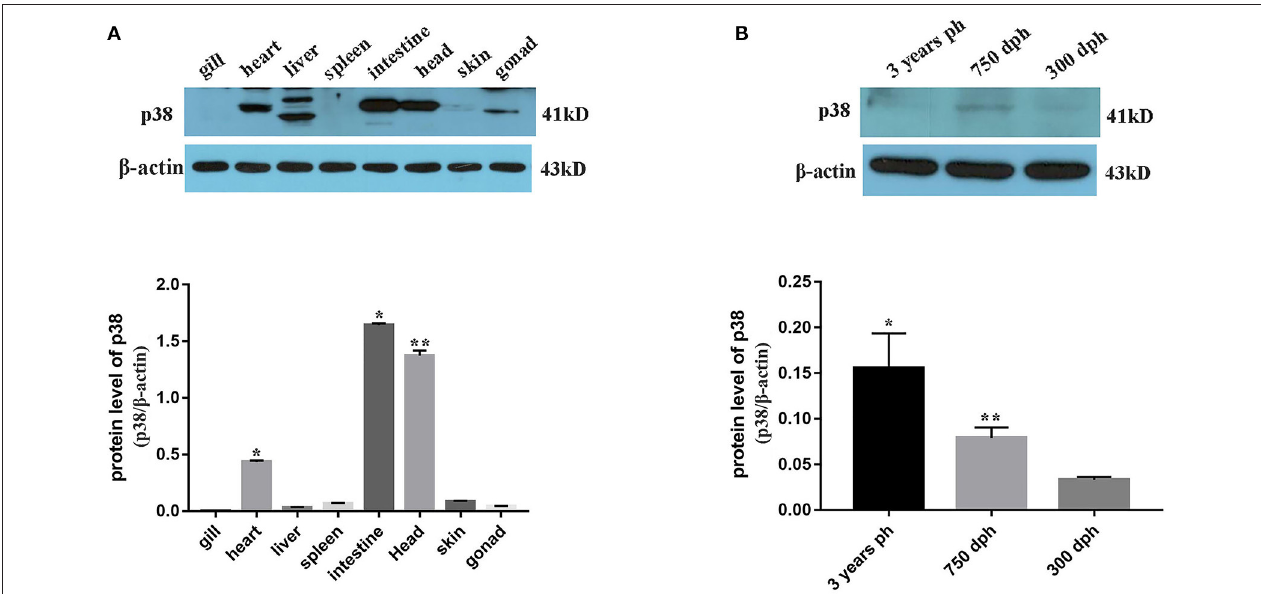
FIGURE 6 | Expression pattern of p38 MAPK protein in B. lenok . (A) The expression level of p38 MAPK protein in 8 tissues. The significance was expressed “*” as a P -value of < 0.05 vs. gill, and “**” as a P -value of < 0.01 vs. gill. (B) The expression level of p38 MAPK protein in gonad at different developmental stages. The significance was expressed “*” as a P -value of < 0.05 vs. 300 dph, and “**” as a P -value of < 0.01 vs. 300